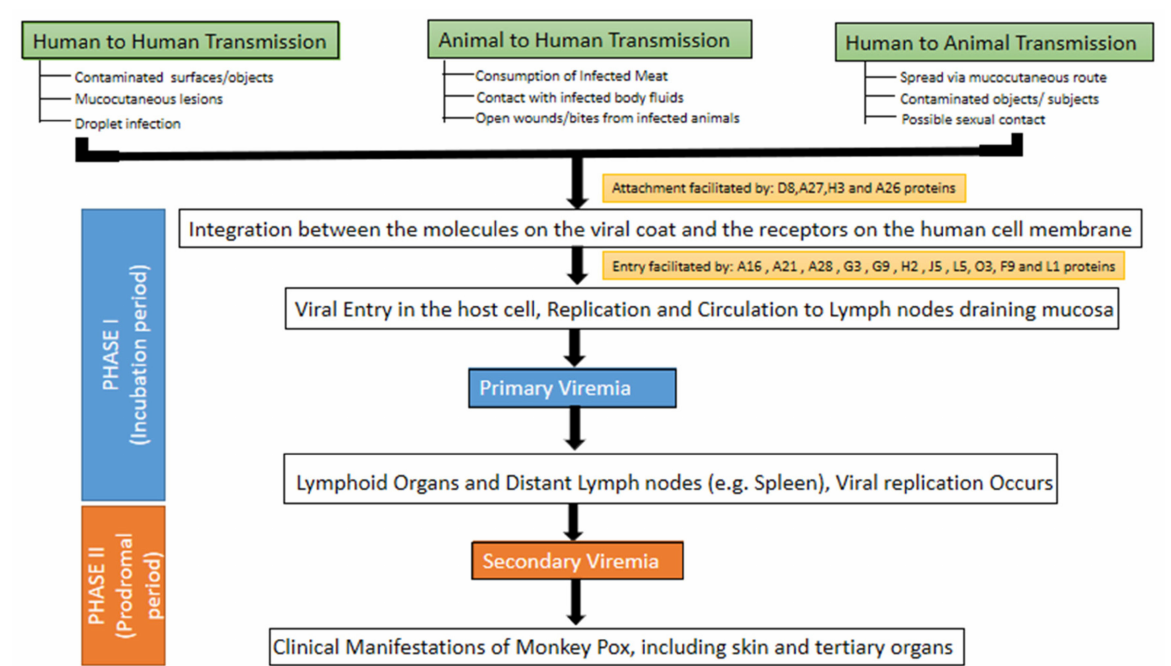
Figure 3. Pathogenesis of monkeypox virus